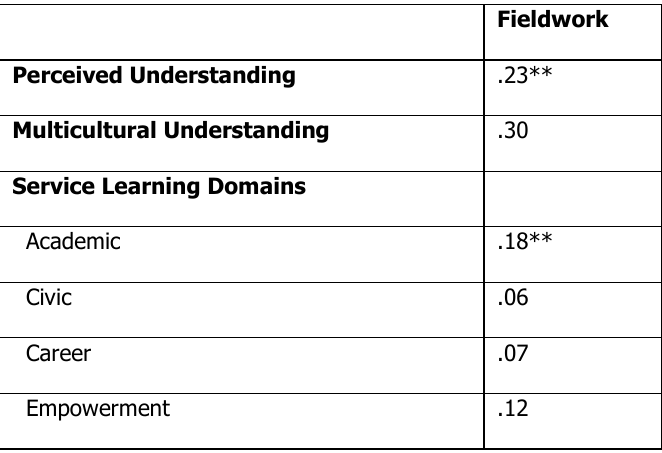
Regression coefficients of CASE courses with fieldwork compared to CASE courses without